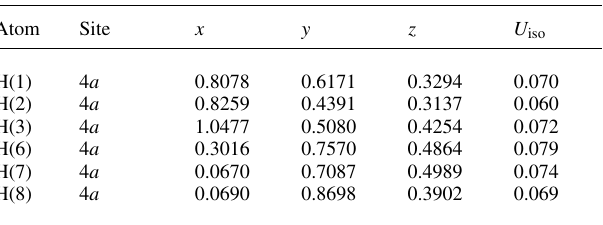
Table 2. Atomic coordinates and displacement parameters (in Å 2 )